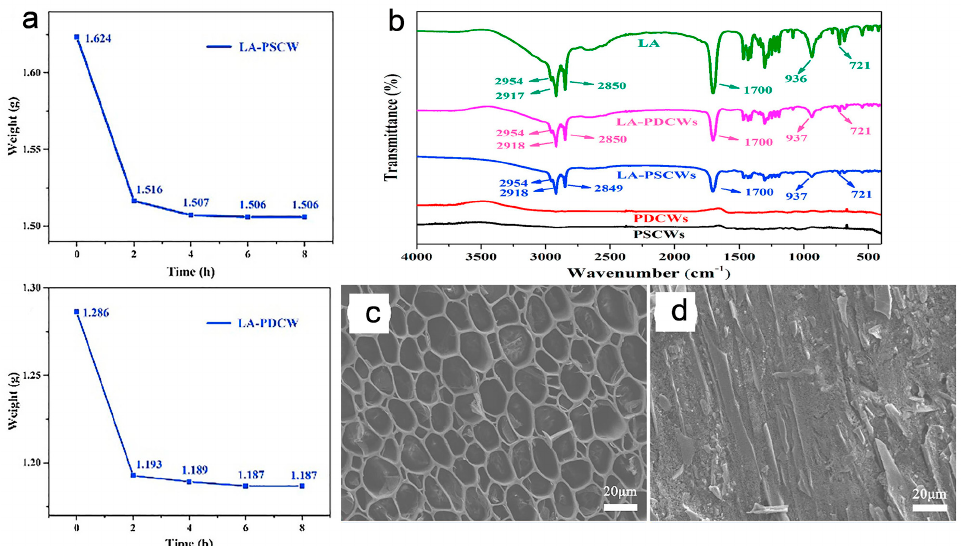
Figure 9. ( a ) Weight-loss graphs of LA/PCWs (time vs. weight) data was taken at 60 °C for 8 h; ( b ) FT-IR spectra of references and PCWs; ( c ) the SEM image of LA showing the complete packaging effect into the PCWs matrix and ( d ) SEM image of LA/PCWs shape-stable composite PCWs. Abbreviations in the figures are as follows: LA = lauric acid, PCW = porous carbonized wood. Adopted with permission [53], copyright 2019, Elsevier B.V.